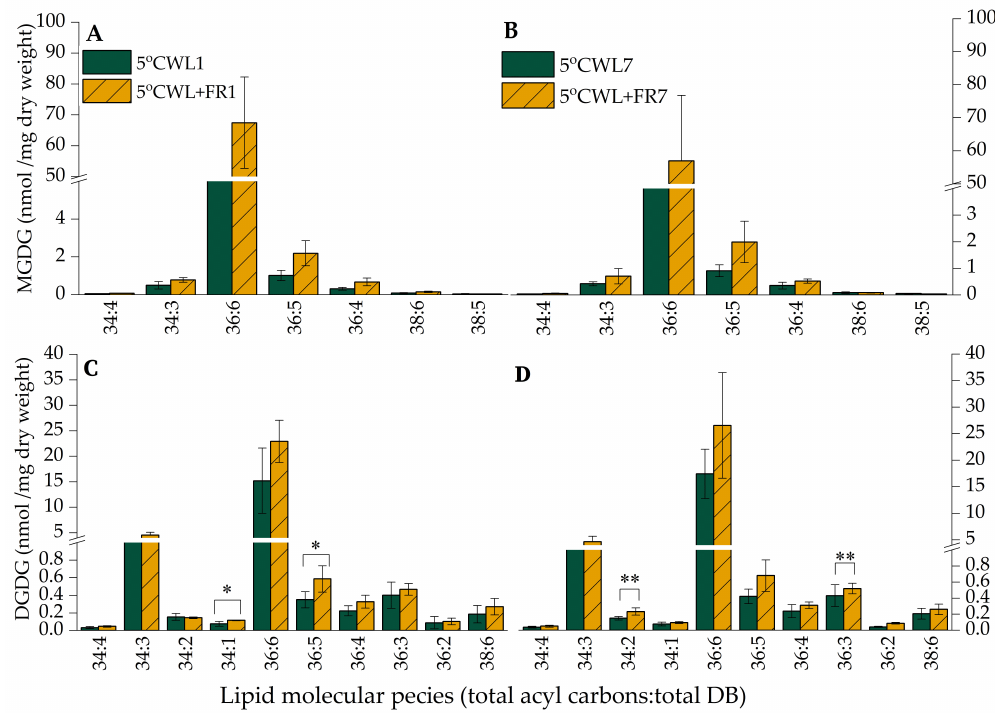
Figure 5. The amount of the most abundant MGDG and DGDG lipid species in barley “Nure” leaves grown at 5 ◦ C for 1 day ( A , C ) and for 7 days ( B , D ) under WL and WL + FR. Lipid species are denoted as total carbon number: total double-bond. Mean values ± SD were calculated from 3 independent biological replicates. Significance levels are designated as * p < 0.1, ** p < 0.05.